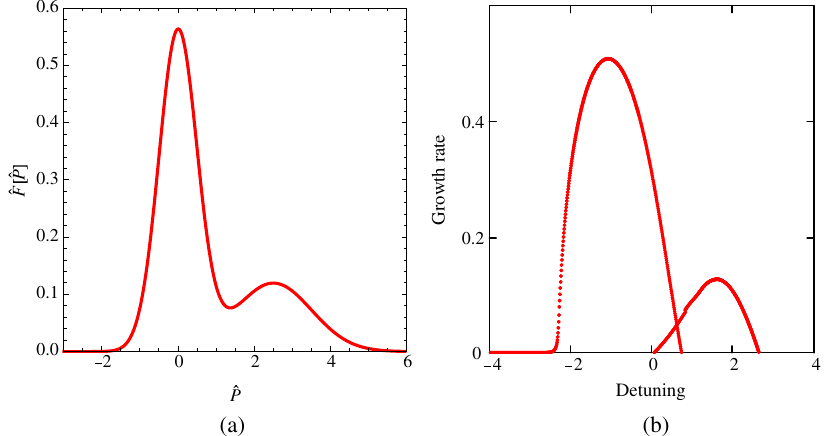
FIG. 7. Energy distribution with three local extrema and its corresponding FEL growth rate. (a) The energy distribution as described in Eq. (57) with A ¼ 0 : 7 , (cid:7) with ^(cid:2) p ¼ 1